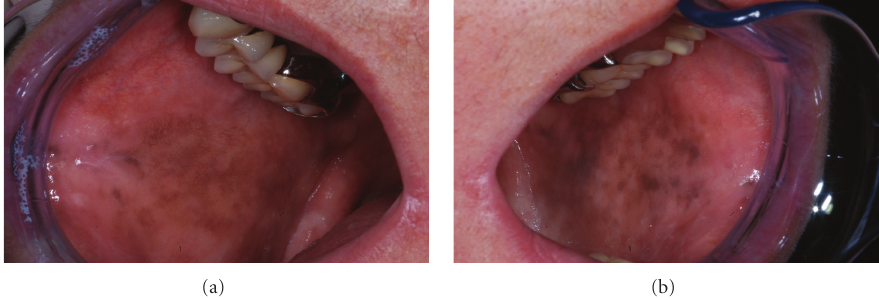
Figure 2: Di ff use macular brown pigmentation on the oral mucosa of right (a) and left (b) cheeks.